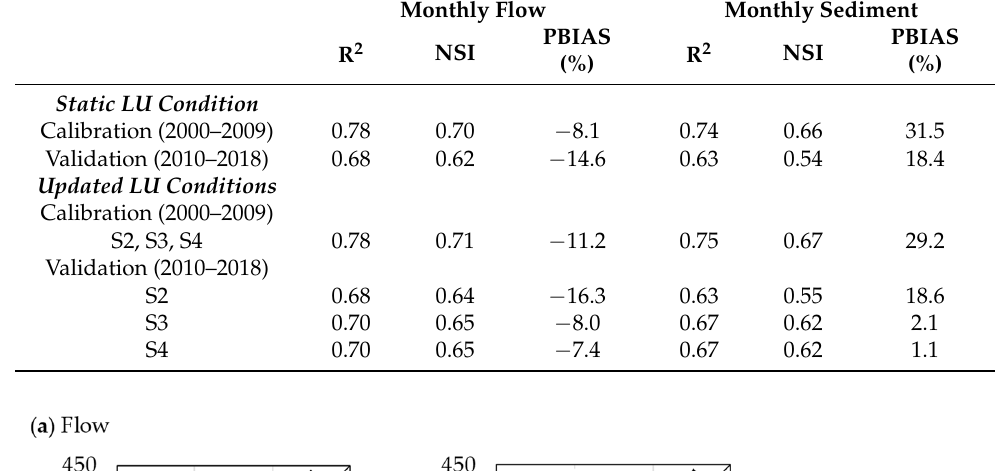
Table 2. The statistical values of R 2 , NSI, and PBIAS in the static land-use condition (S1), featuring the 2005 land-use map during entire simulation period of 2000–2018, and the updated land-use conditions (S2, S3, and S4). R 2 : coefficient of determination; NSI: Nash–Sutcliffe index; PBIAS: percent bias.